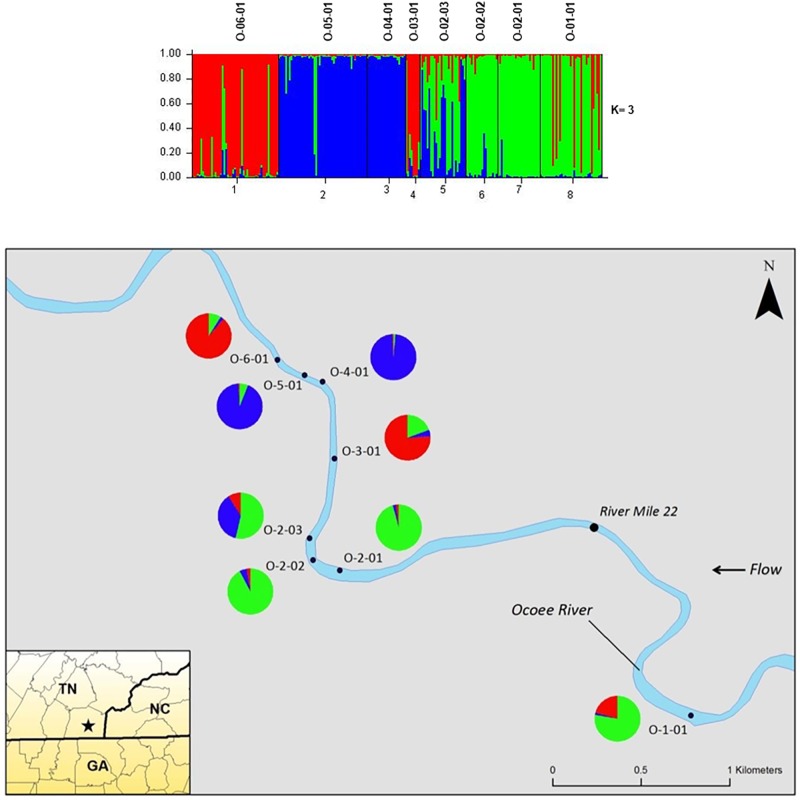
Bar plots of individual Bayesian assignment probabilities of nuclear microsatellites for Pityopsis ruthii Ocoee River populations using the program STRUCTURE for three clusters. Each vertical line represents an individual’s probability of belonging to one of k clusters (represented by different colors) or a combination of if ancestry is mixed. Map of the sampled populations. Pie charts correspond to the population assignment for the three genetic groups defined by the Bayesian assignment of STRUCTURE.